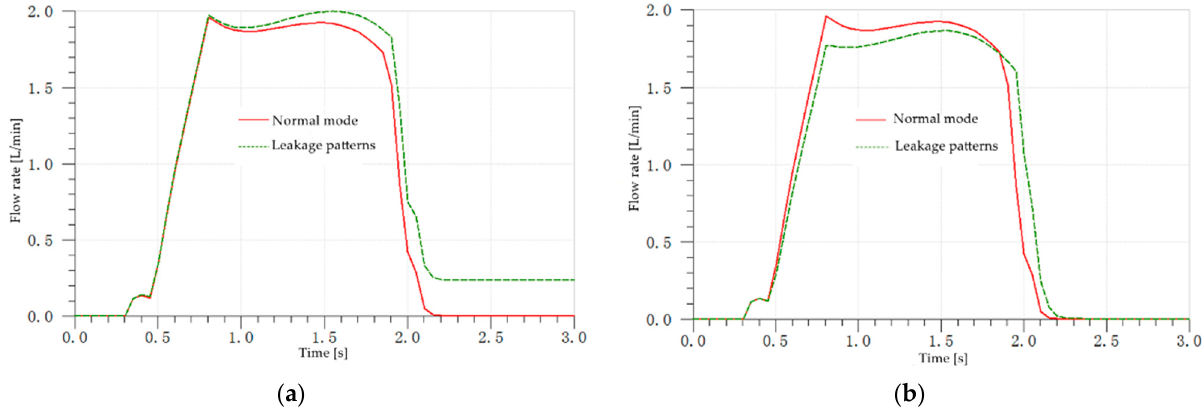
Figure 7. Flow characteristics of faults mode. ( a ) Flow characteristics of leak mode. ( b ) Flow characteristics of blockage